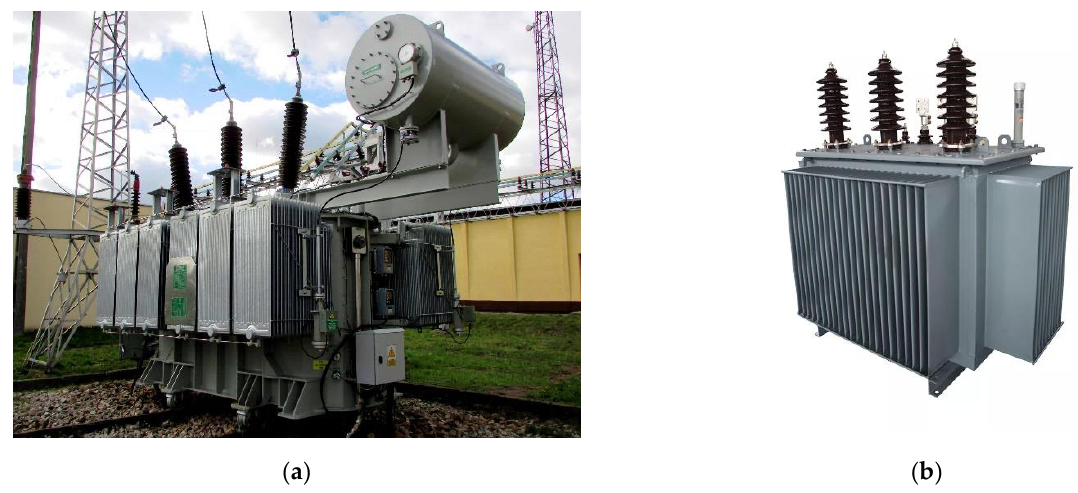
Figure 1. Application of liquid-paper insulations in power transformers: ( a ) Free breathing power transformer [25]; ( b ) Hermetic transformer [26].